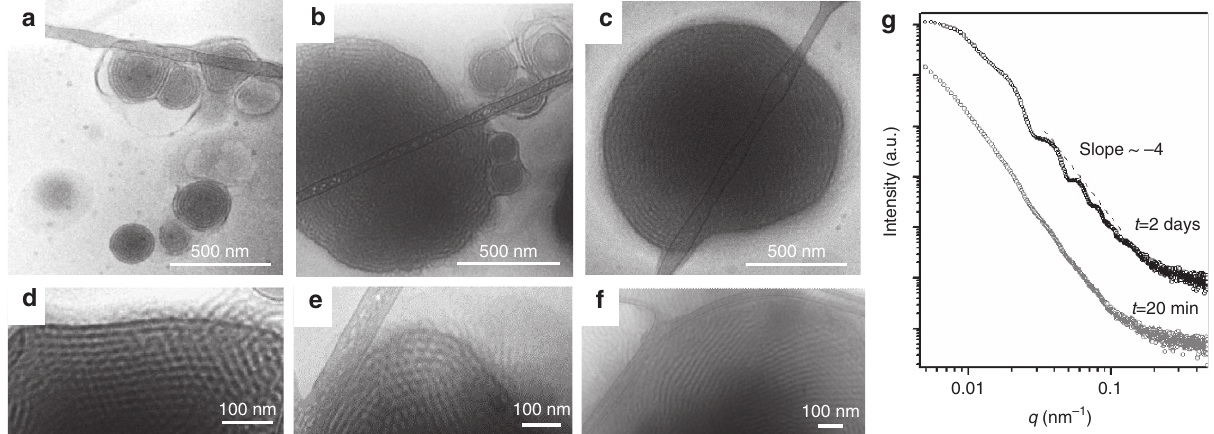
Figure 4 | Structure evolution. Cryo-TEM images of the self-assembled aggregates of PAA 45 - b -PIL 23 recorded after 1h ( a ), 1 day ( b ) and 2 days ( c ) of adding water to the THF solution. Cryo-TEM images of the self-assembled aggregates of PAA 45 - b -PIL 23 aged at 21 (cid:2) C ( d ), 50 (cid:2) C ( e ) and 80 (cid:2) C ( f ). Self- assembling conditions: 2mgml (cid:2) 1 THF solution of PAA 45 - b -PIL 23 , water/THF volume ratio ( R) ¼ 1.6. ( g ) SAXS pattern of PAA 45 - b -PIL 23 solution measured after 20min and 2 days after adding